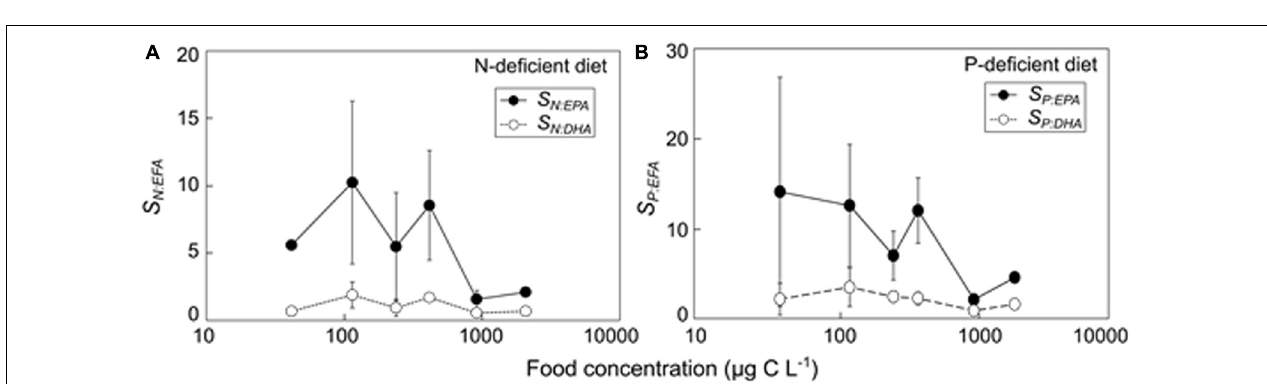
FIGURE 4 | The strength of limitation of deficient nutrient relative to essential fatty acid (EFA: EPA and DHA) on zooplankton production in response to different food quantity: (A) the strength of limitation of N relative to EPA and DHA ( S N : EPA and S N : DHA ) as a function of food concentrations under N deficiency, and (B) the strength of limitation of P relative to EPA and DHA ( S P : EPA and S P : DHA ) as a function of food concentrations under P deficiency. Data are shown as mean values ± SD. Note the log scale is used.